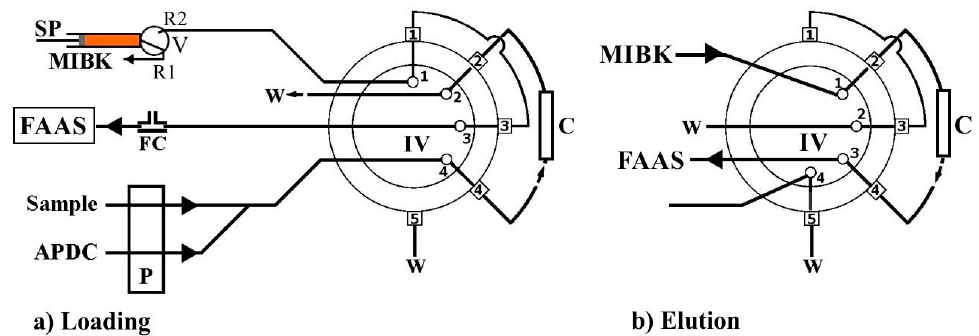
Figure 1. Schematic diagram of the FI-FCSE-FAAS method for Pb(II) and Cr(VI) determination. IV; injection valve in ( a ) loading and ( b ) elution position; SP, syringe pump; P, peristaltic pump; C, fiber coated sorbent extraction (FCSE) column; FC, flow compensation; FI, flow injection; FAAS, flame atomic absorption spectrometry.